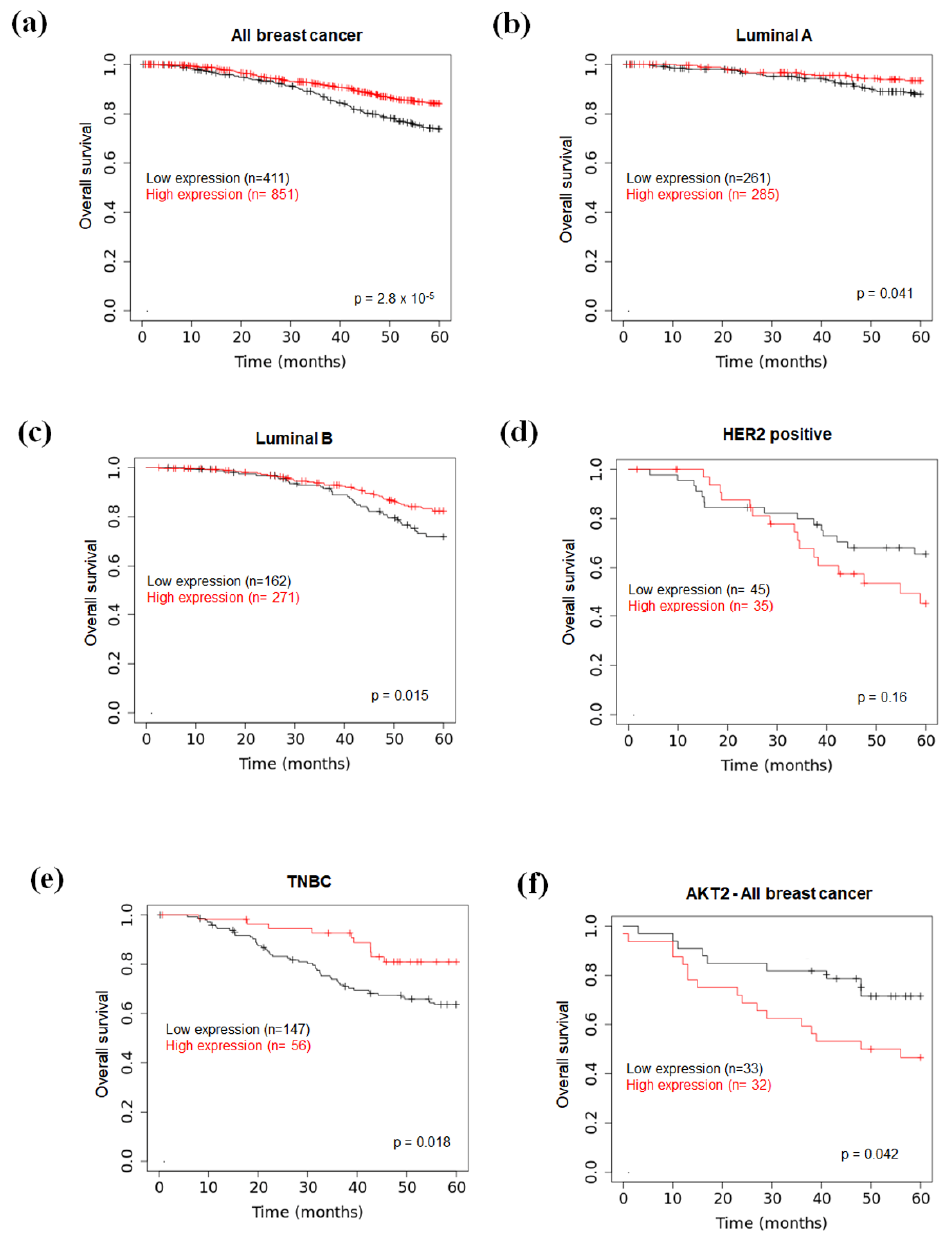
Figure 7. Kaplan–Meier survival analysis of BC patients based on miR-126 expression and AKT2 protein levels. Graphs were downloaded from the KM plotter website (https://kmplot.com/analysis/, accessed on 26 December 2021) [52]. Comparison of 5-year overall survival between patients with high and low miR-126 expression levels in ( a ) all breast cancers, ( b ) luminal A, ( c ) luminal B, ( d ) HER2 positive, and ( e ) TNBC tumors. Data were from METABRIC database. ( f ) Comparison of 5-year overall survival between BC patients with high and low AKT2 protein levels. Data were from [53].